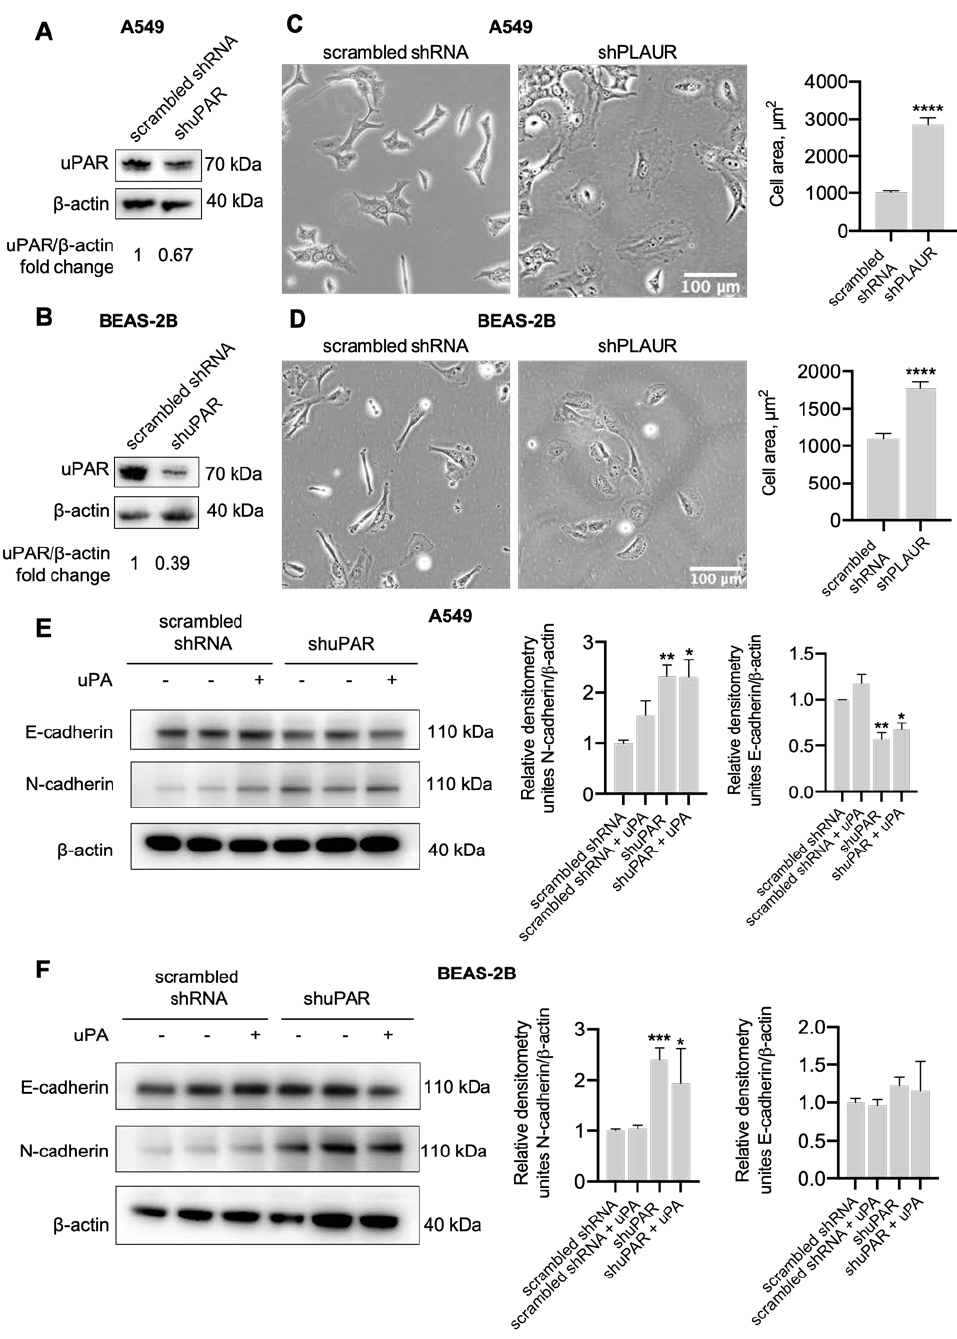
Figure 8. uPAR expression affected the morphology of human lung epithelial cells and changed the expression of EMT-related markers: ( A ) The level of uPAR protein expression in the obtained A549-based stable cell lines. β -actin was used as a control of protein load. Densitometric analysis of uPAR